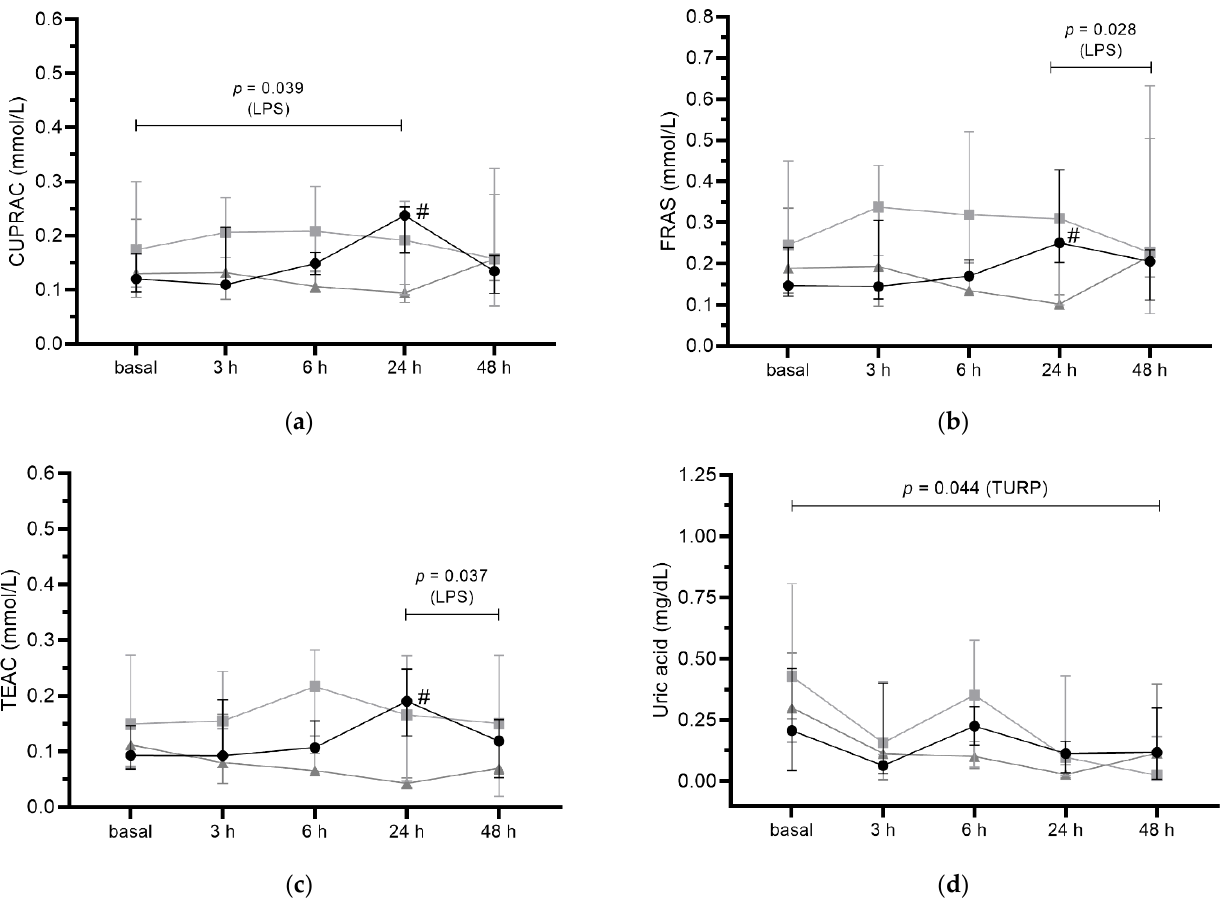
Figure 1. ( a ) Cupric reducing antioxidant capacity (CUPRAC), ( b ) ferric reducing ability of saliva (FRAS), ( c ) Trolox equivalent antioxidant capacity (TEAC), and ( d ) uric acid concentrations in control ( ▲ ), lipopolysaccharide (LPS)-treated pigs ( ● ), and turpentine (TURP)-treated pigs ( ■ ) before (basal) and after 3 h, 6 h, 24 h, and 48 h the inoculations. The results are presented as median with an interquartile range. # , significantly different from the control group ( p < 0.05; one-way ANOVA with Sidak’s multiple comparisons test). Differences between times are indicated by bars and the obtained p -value (one-way ANOVA with Tukey’s multiple comparison test).